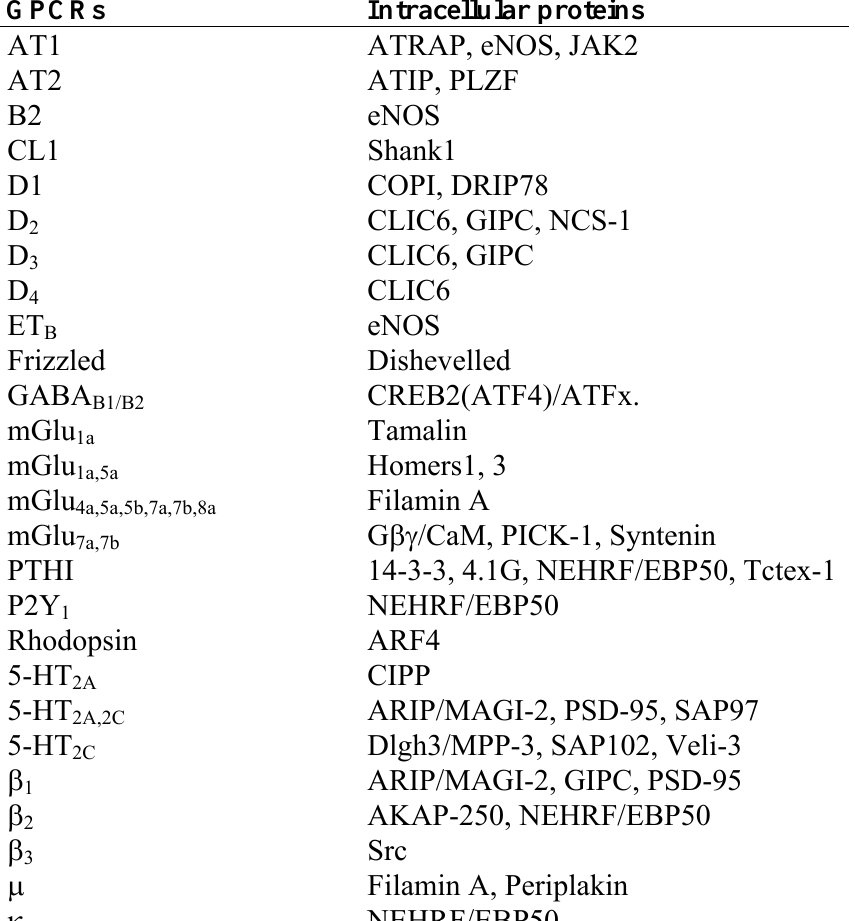
Table 1. Intracellular proteins coupled with the C-terminus of